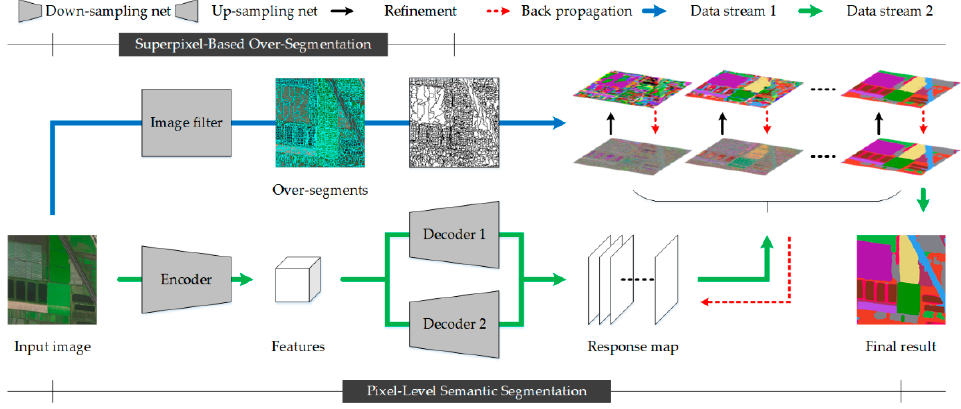
Figure 2. Framework of our proposed conditional co-training (CCT) for truly unsupervised remote sensing image segmentation in coastal areas.